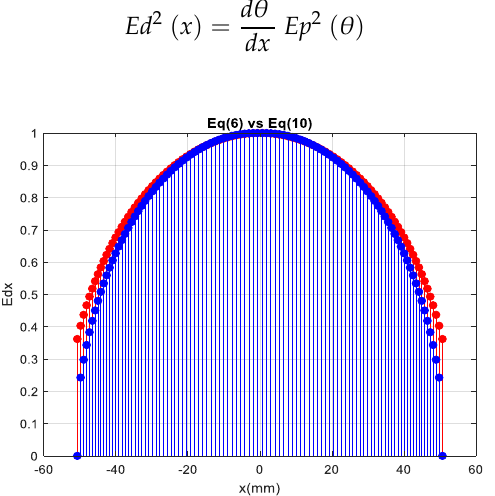
Figure 7. Comparison of aperture distribution .